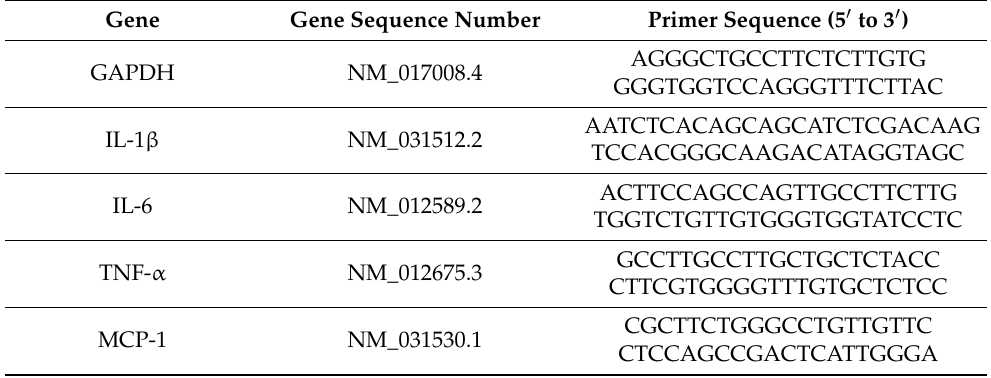
Table 1. Primer sequences used in this study. Gene Gene Sequence Number Primer Sequence (5 (cid:48) to 3 (cid:48)